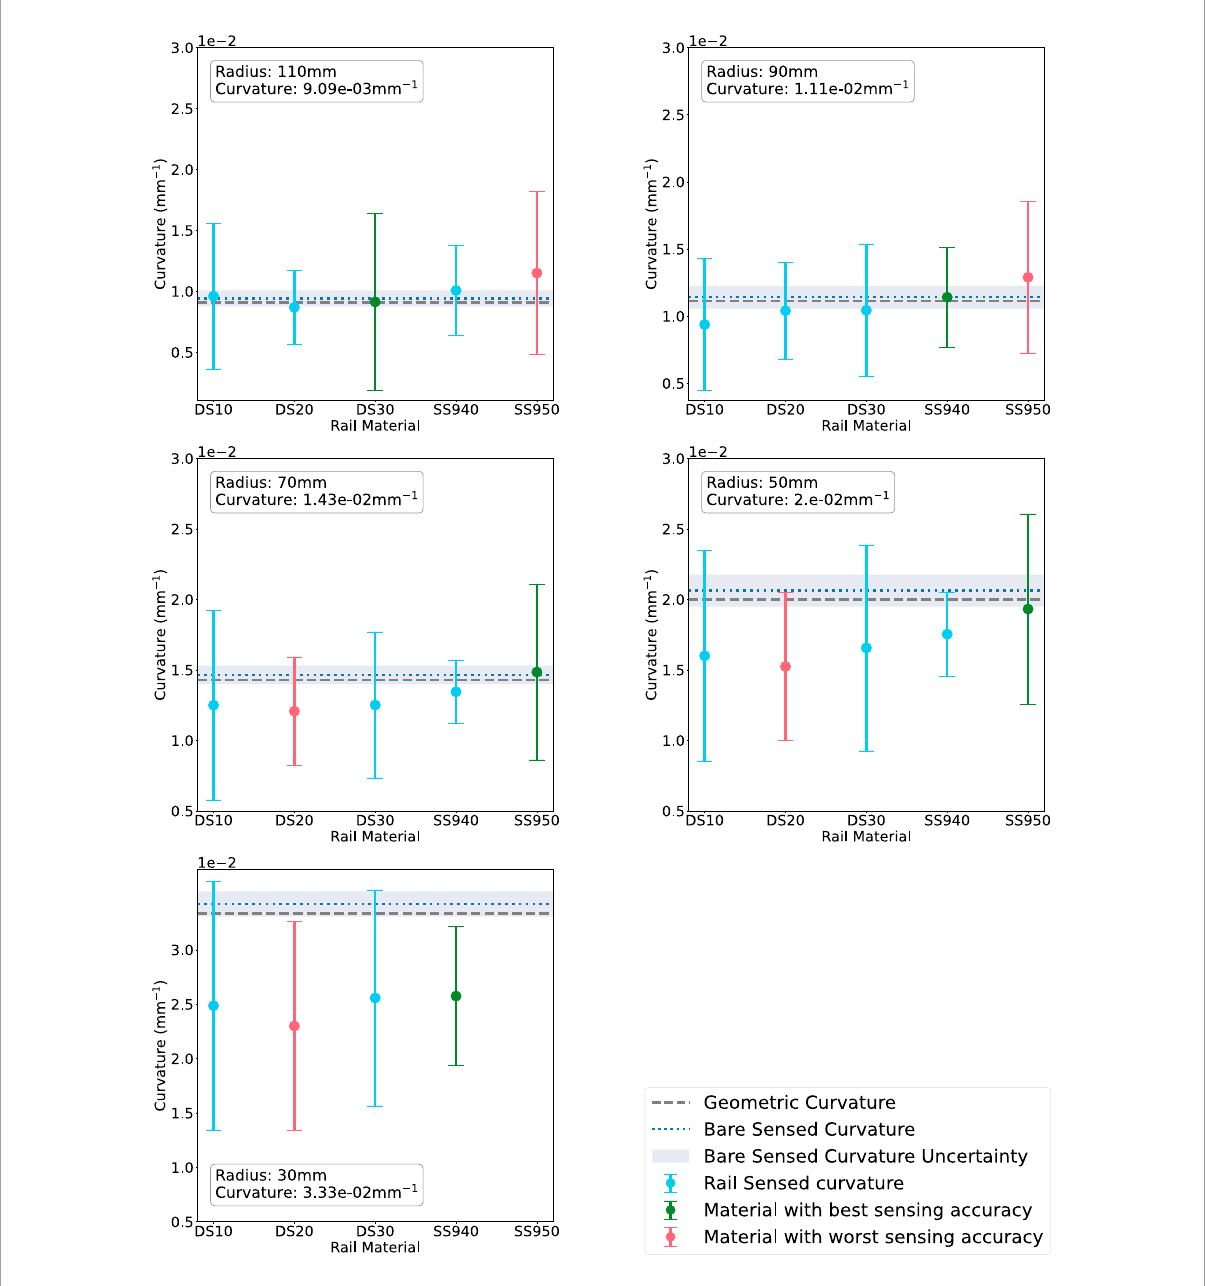
FIGURE 8 Rail-sensed curvature at each radius (decreasing L-R) on the rigid phantom. The materials on the x -axis are in order of increasing material stiffness. Green corresponds to the rail with best sensing accuracy, red to the